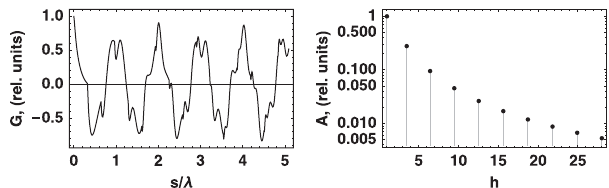
FIG. 7. Electron density distribution and normalized wakefield. See text for explanation of the specific plots.